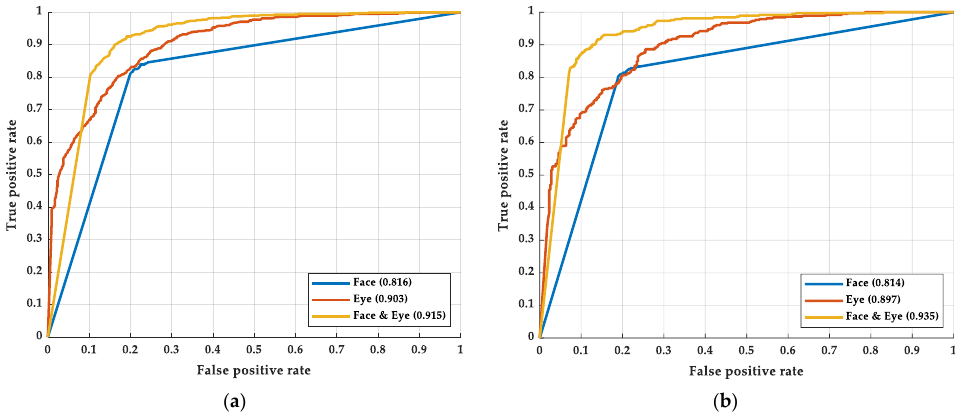
Figure 5. The ROC curve of the experimental results: ( a ) the results of the training process and ( b ) the results of the testing process.